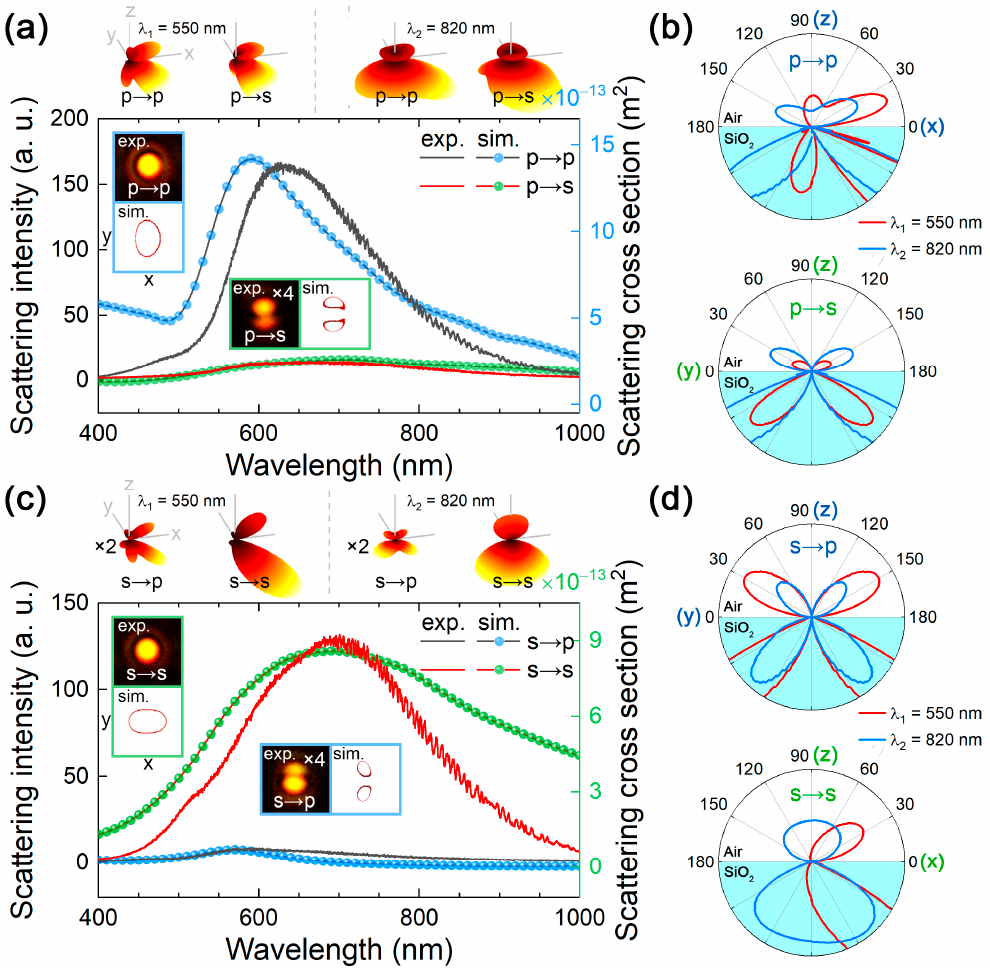
Figure 4. Scattering spectra measured and simulated for a GNS with d ~ 280 nm, which is excited by using p - and s -polarized light and detected by using a p - and s -polarized analyzer. ( a ) Excited by p -polarized light and detected by using a p - and s -polarized analyzer. ( b ) Two-dimensional radiation patterns on the xoz and yoz planes of the GNS excited by using p -polarized light at 550 and 820 nm and detected by using a p - and s -polarized analyzer. ( c ) Excited by s -polarized light and detected by using a p - and s -polarized analyzer. ( d ) Two-dimensional radiation patterns on the xoz and yoz planes of the GNS excited by using s -polarized light 550 and 820 nm detected by using a p -/ s -polarized analyzer. The two-dimensional radiation patterns recorded by using a CCD and those on the xoy plane and the three-dimensional radiation calculated by using the FDTD method are shown in the insets of ( a ) and ( c ).